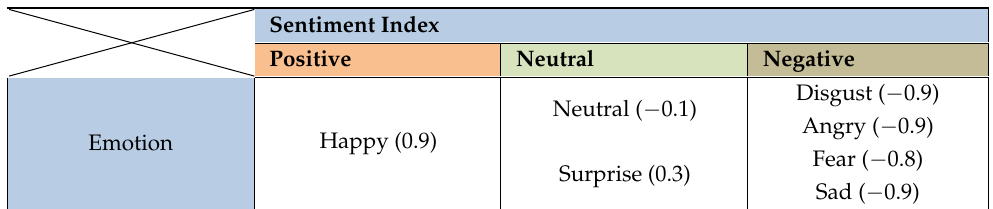
Table 1. Sentiment indexes of emotion.